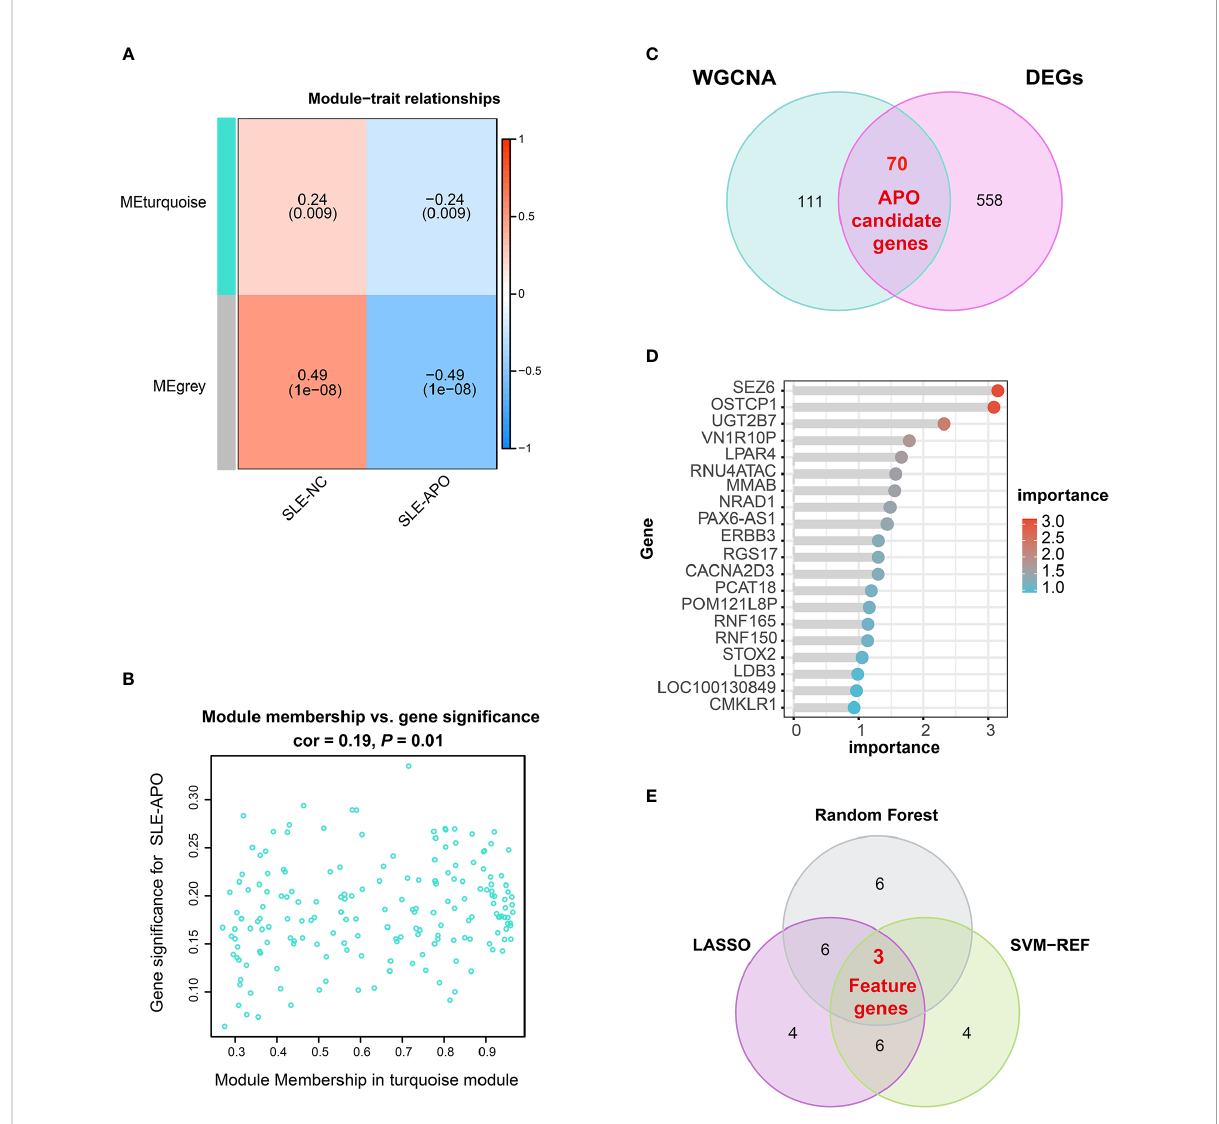
FIGURE 3 Identi fi cation of feature genes. (A) Heatmap of the correlation between module eigengenes and SLE-NC and SLE-APO. (B) Scatter plot for correlation between the gene signi fi cance for SLE-APO and Module Membership in the turquoise module. (C) Venn diagram illustrating the intersections of WGCNA-identi fi ed co-expressed genes and DEGs. (D) Genes ranked by importance for the RF algorithm. (E) Venn diagram displaying 3 feature intersecting genes according to the SVM-RFE, RF and LASSO